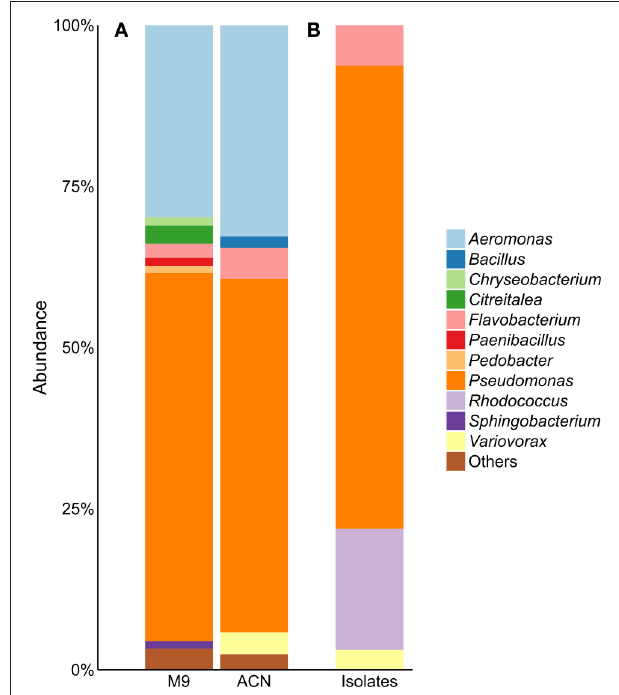
FIGURE 1 | (A) Community composition of acetonitrile-enrichment and control culture and (B) 16S rRNA gene analysis of 33 acetonitrile-degrading isolates; “Others” refers to genera with an abundance of < 1%. M9, control; ACN, acetonitril